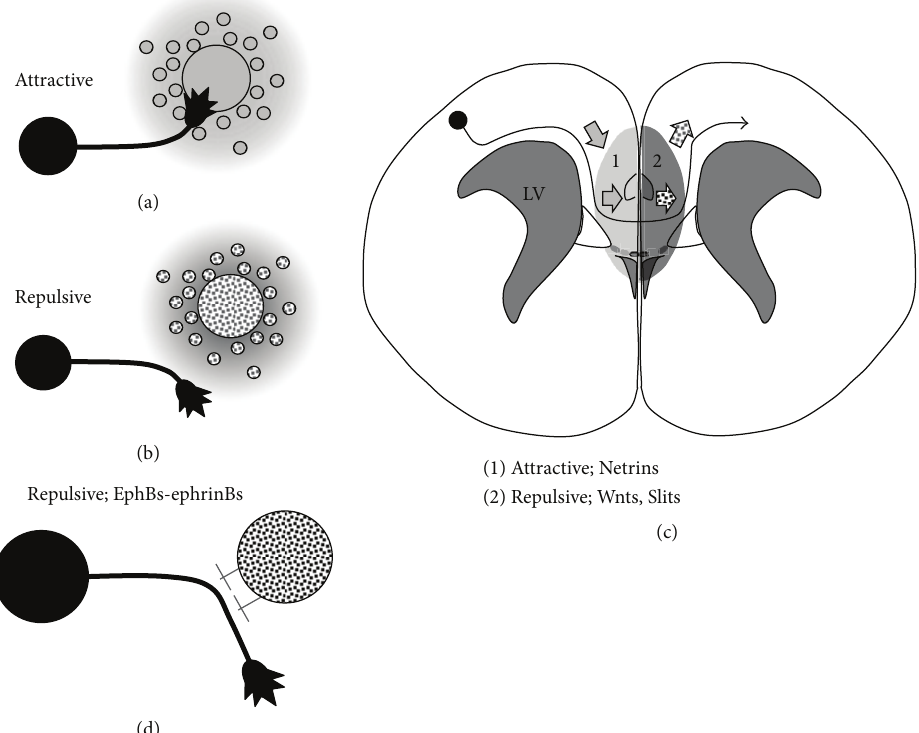
Figure 2: Glia-axon interactions in the development of callosal axons. (a) and (B) Axon guidance by long-range molecules, attractive (a) or repulsive (b) signals. Glial populations (gray and dotted circles in (a) and (b), resp.) secrete guidance molecules, forming a concentration gradient, which navigates the callosal axons during their development (c). (d) Axon guidance by short-range molecules. Repulsive molecules expressed on the cell membranes navigate callosal axons through repulsive and bidirectional cell-cell contact